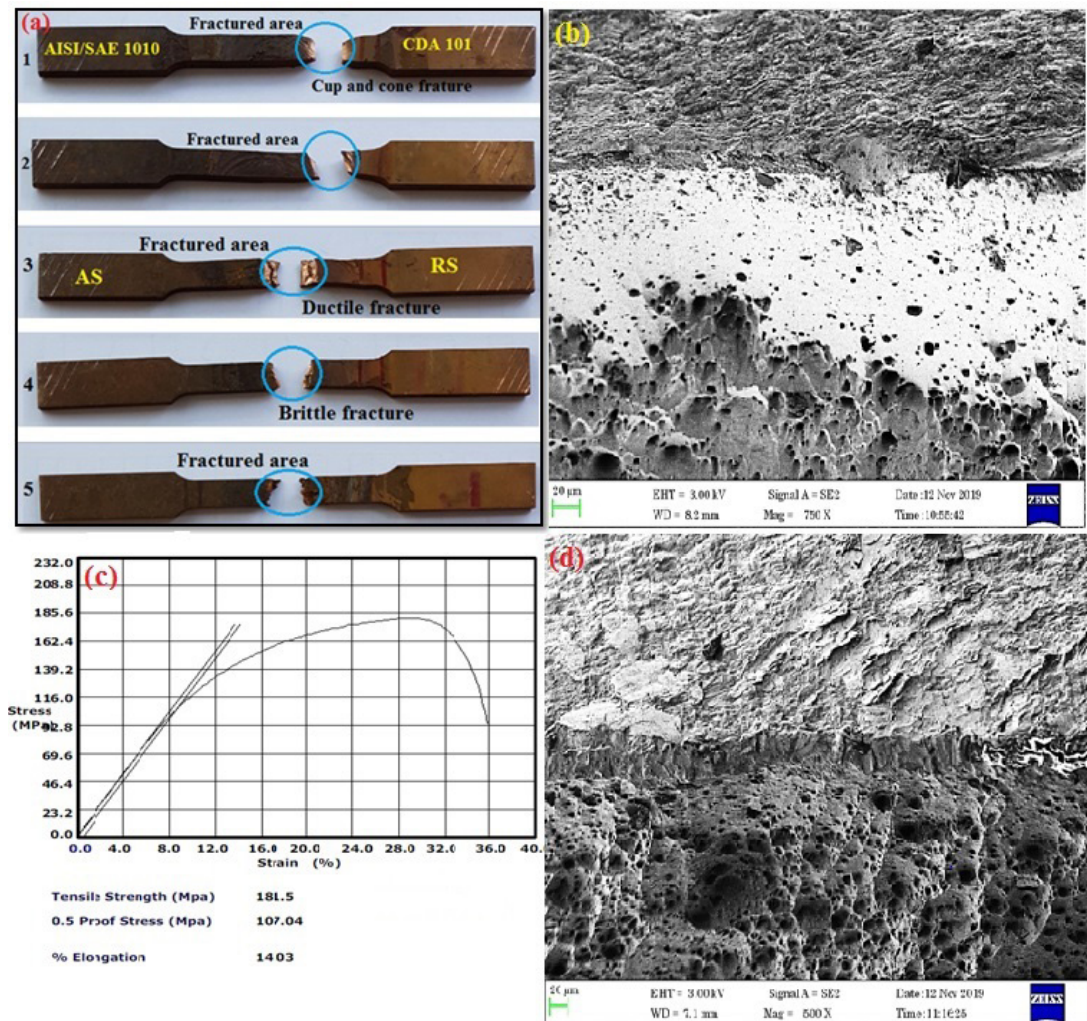
Figure 10. Tensile measurements: (a) fracture locations of the joint, (b,c) tensile rupture features of the weld joint, and (d) stress–strain curv e for fractured